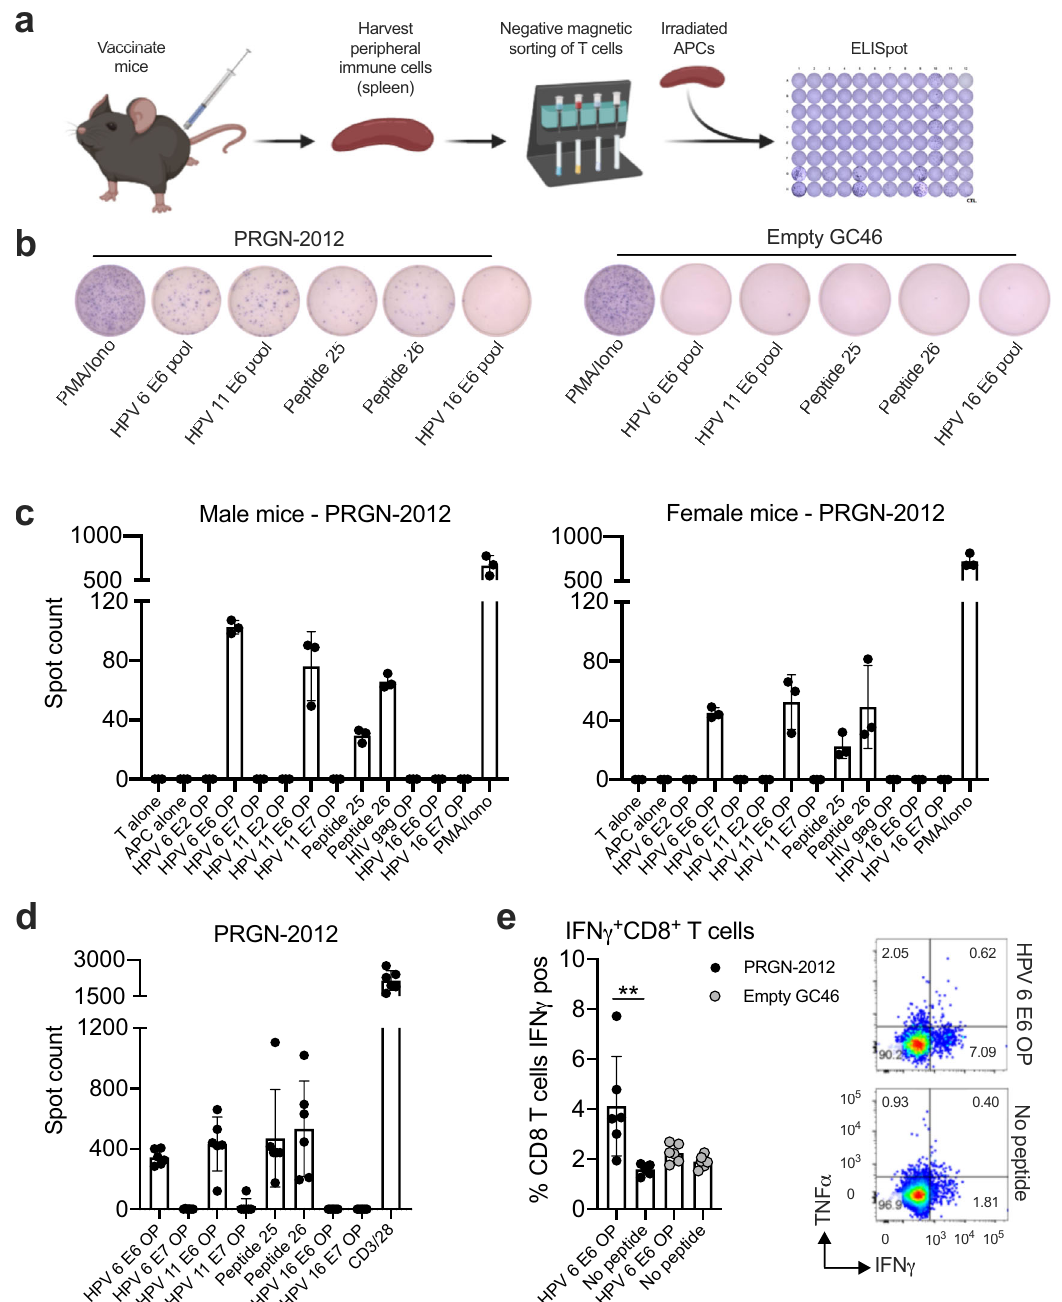
Fig. 3 In vivo vaccination with PRGN-2012 induced immunity against an E6 epitope shared between HPV6 and HPV11. a Experimental design of peripheral T lymphocytes from wild-type C57BL/6 mice vaccinated with PRGN-2012 assessed for HPV antigen-speci fi c immune responses. b Photomicrographs of representative ELISpot wells demonstrating responses to HPV6 and 11 overlapping 15-mer peptide pools as well as synthesized minimal peptides following in vivo vaccination with PRGN-2012 but not empty GC46. c Quanti fi cation of IFN γ spots in vaccinated male ( n = 3) and female ( n = 3) mice. d Quanti fi cation of IFN γ spots in an independent validation in vivo vaccination experiment in female wild-type C57BL/6 mice ( n = 5). e Quanti fi cation (left) and representative fl ow cytometry dot plots (right) of CD8 + T-lymphocyte IFN γ production following assessment of HPV antigen-speci fi c T-lymphocyte responses from mice vaccinated with PRGN-2012 or empty GC46, measured by intracellular fl ow cytometry ( n = 6/group). Dot plots show gated live, CD3 + CD8 + T lymphocytes from mice vaccinated with PRGN-2012. Similar experimental results were observed in three independent experiments. APC antigen presenting cell, OP overlapping peptides. ** p < 0.01; Student ’ s t therapeutic vaccination delayed tumor growth in this syngeneic We demonstrated that vaccination with PRGN-2012 elicits lrHPV- model of a neoplasm expressing HPV6 E6 antigen. speci fi c T-cell responses in vitro and in vivo. Further, therapeutic The rationale behind therapeutic vaccination is the delivery of vaccination induced migration of lrHPV-speci fi c CD8 + T lympho- an immunogenic payload (nucleic acids or proteins) to antigen cytes into tumor parenchyma. Although tumors were not cured,